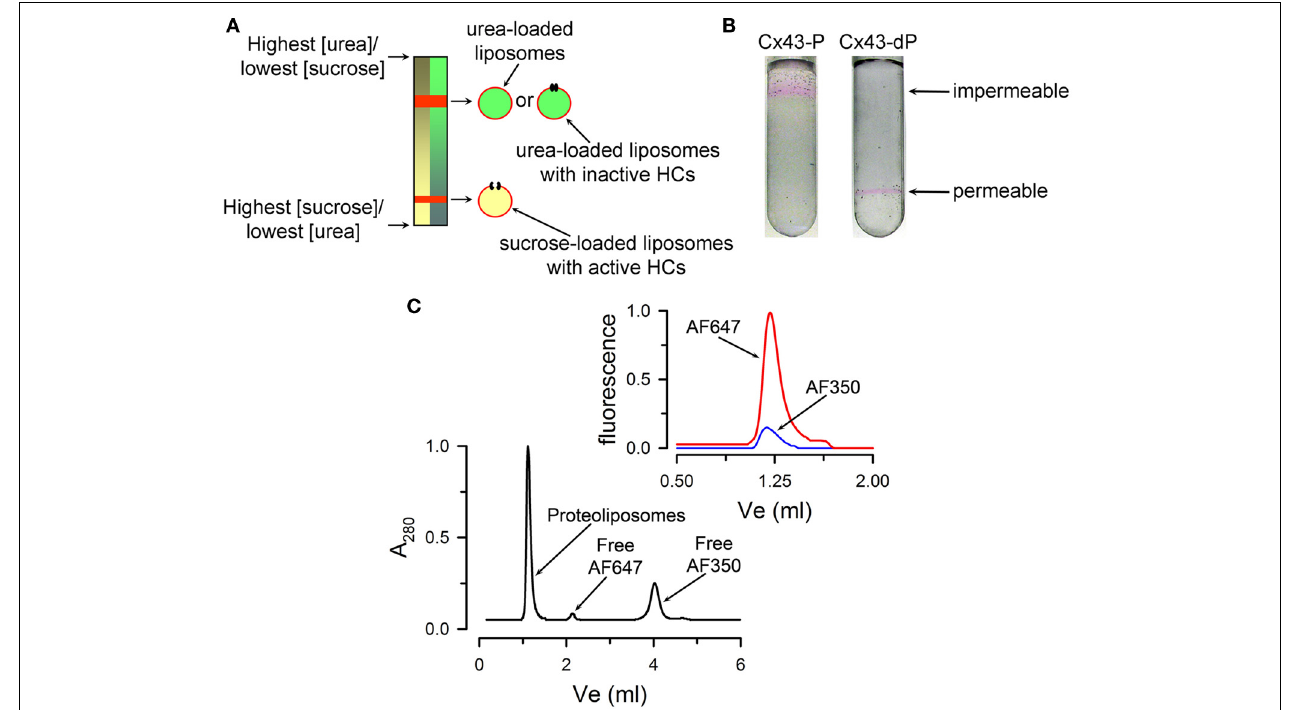
FIGURE 2 | Qualitative transport assays. (A) Schematic representation of the transport-specific assay. (B) Typical migration of liposomes containing purified Cx43 HCs on an isoosmolar linear sucrose density gradient. Images showing the position of the rhodamine B-labeled proteoliposomes after centrifugation. The HCs were formed by either fully dephosphorylated Cx43 (Cx43-dP, sucrose permeable) or Cx43 fully phosphorylated by PKC (all six Ser-368 residues phosphorylated, Cx43-P, impermeable to sucrose). Reconstitution was at an average HC/liposome ratio of 2.3. (C) Permeability